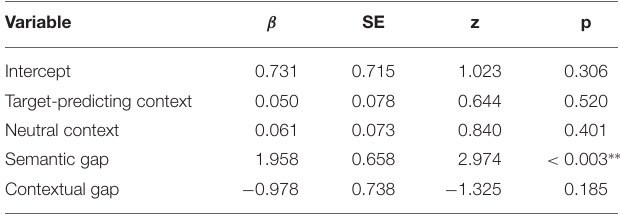
TABLE 6 | Regression coefficients of the logistic linear mixed effects model including the responses from the blinded conditions (second half) of Experiment 2. Variable β